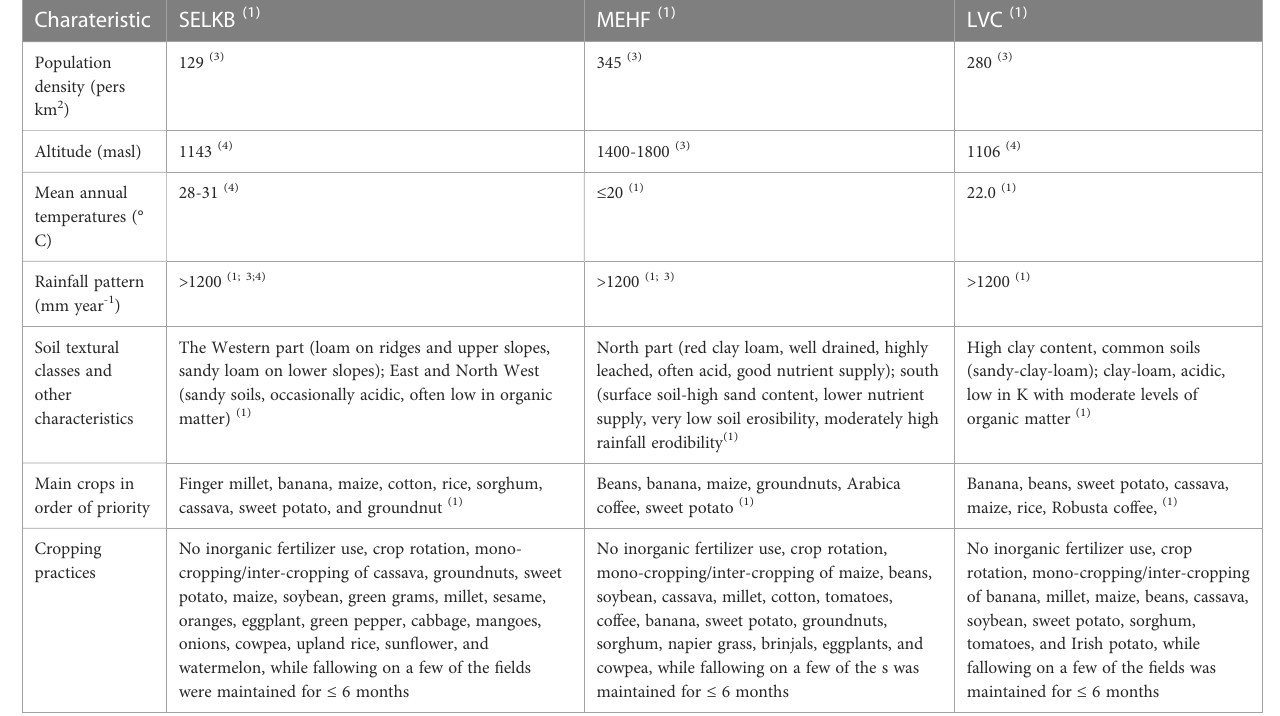
TABLE 1 Agro-ecological characteristics of the study areas.